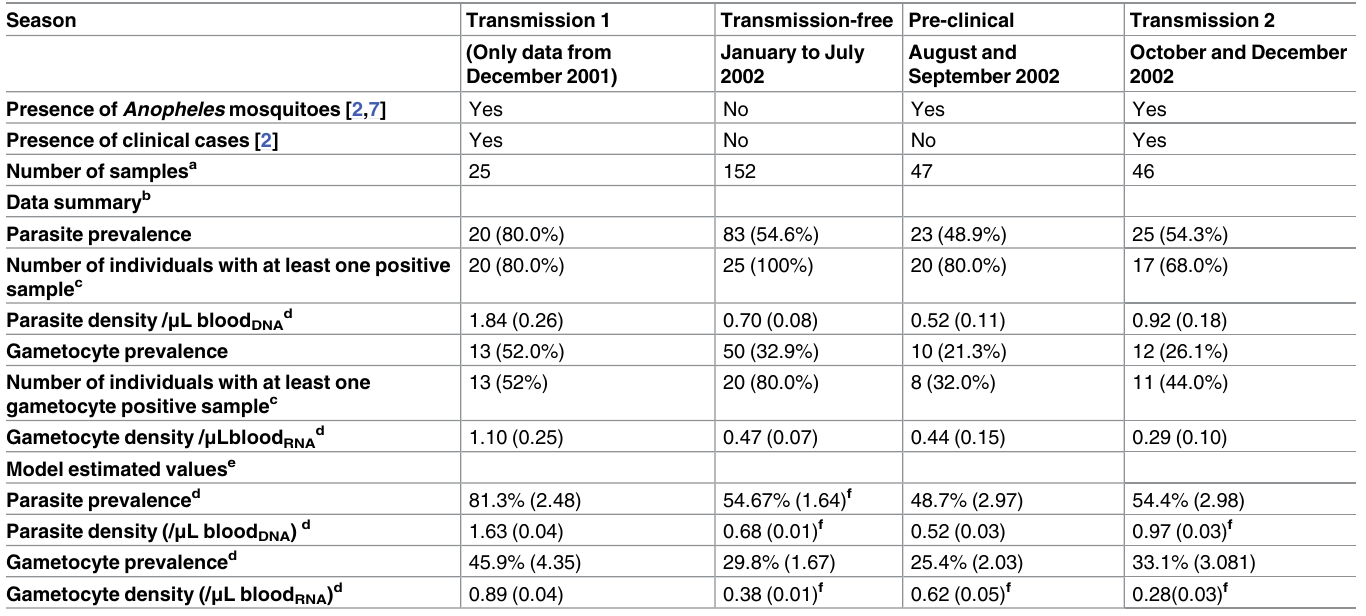
Table 1. Prevalence and densities of total parasitesand gametocytesin samples taken from 25 individuals selected during transmission